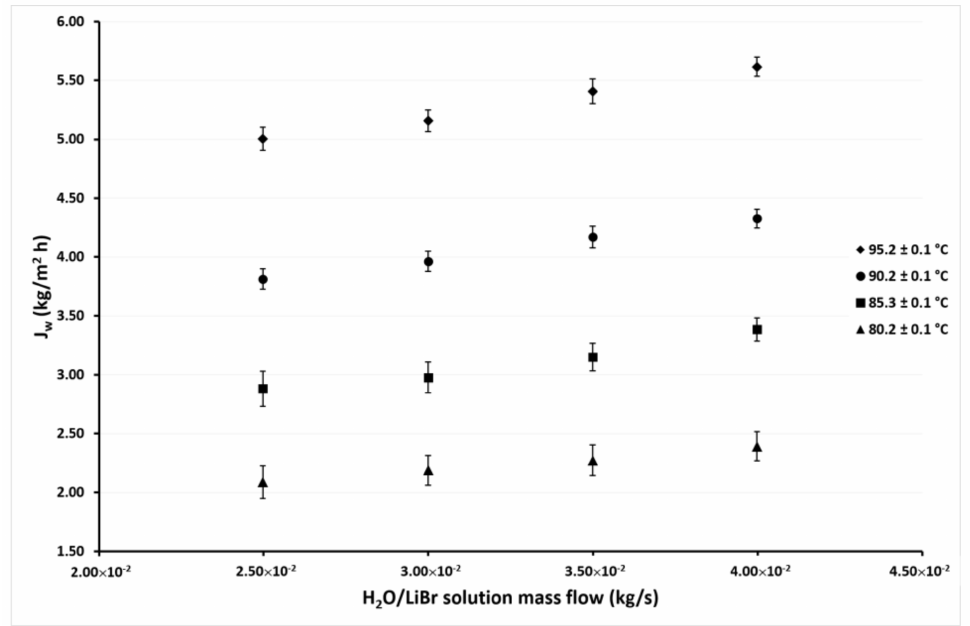
Figure 7. Desorption rate as a function of the ˙m LiBr with T cw,in = 35.1 ± 0.1 ◦